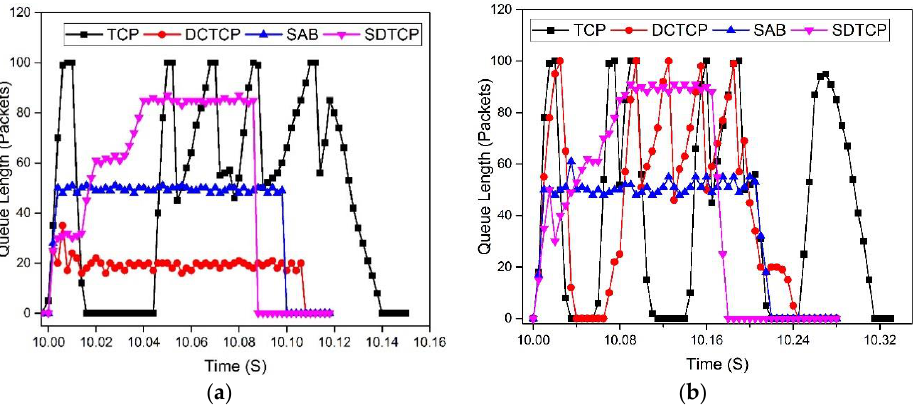
Figure 12. Queue length dynamics with 500 KB flow size: ( a ) 20 burst flows; and ( b ) 50 burst flows.